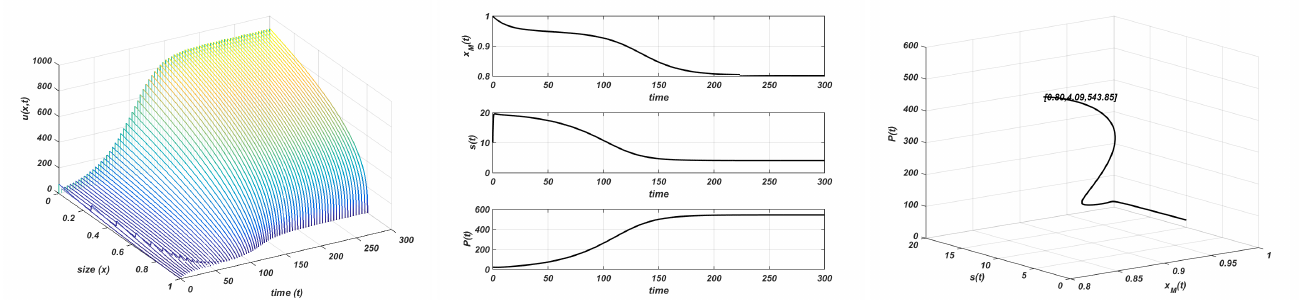
Figure 5. Chemostat growth. r = 4.5 and K = 20.2. Stable equilibria. Plot on the left : evolution of the structure of the consumer; plot in the centre : evolution of the maximum size, resource, and total consumer population to the equilibrium; plot on the right : orbit followed towards the equilibrium ( 0.80,4.09,543.85 )